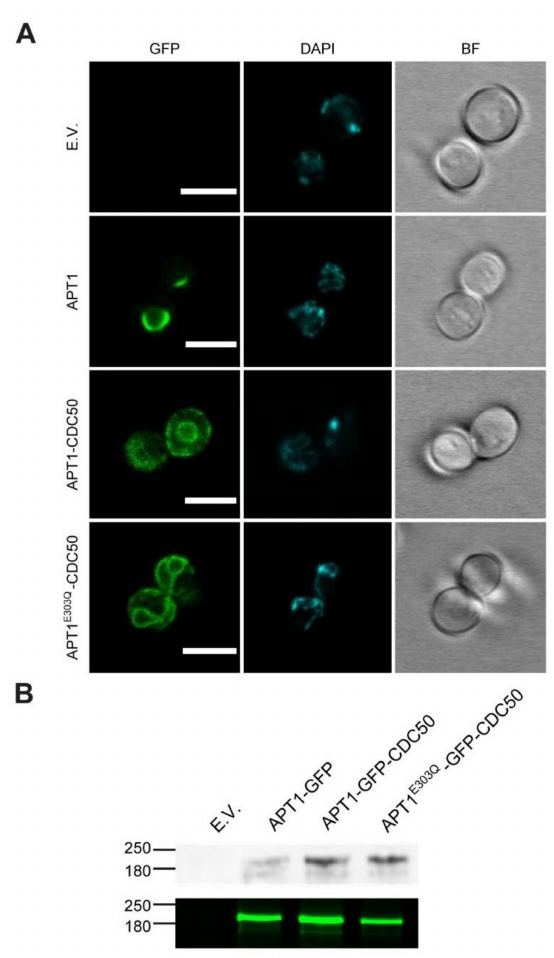
Figure 4. Expression and localization of Apt1p in S. cerevisiae . ZHY709 cells were transformed with an empty plasmid vector (E.V.) or with plasmids encoding the indicated Apt1p/Cdc50p variants. Gene expression was induced by growth in galactose medium at 25 ◦ C. ( A ) Representative fluorescence (GFP) or bright-field (BF) confocal images. DAPI (blue) was used to identify nuclei. Scale bars, 5 µ m. ( B ) In-gel fluorescence (lower panel) and Western blot analysis (upper panel) of total protein extracts or total membrane preparations. Blots were stained with anti-FLAG antibody. The mobilities of marker proteins of known mass (kDa) are indicated on the